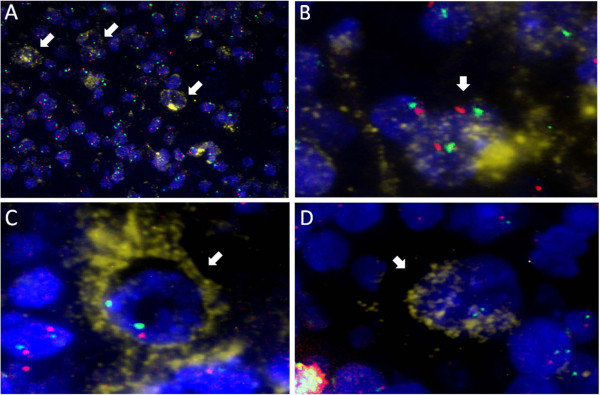
Results of FICTION analysis. FICTION assay combining CD30-expressing cells (yellow) and FISH probes for A20 (red) and chromosome 6 centromere (green). White arrows indicate CD30-positive cells. (A) Low-power field (×300). (B) Normal cells. (C) Heterozygous deletion. (D) Homozygous deletion (×1,000).